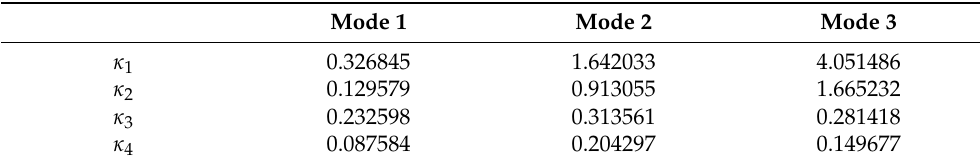
Table 1. Values of dimensionless rotational stiffness of spring κ i in Equation (8) for three modes after [23].